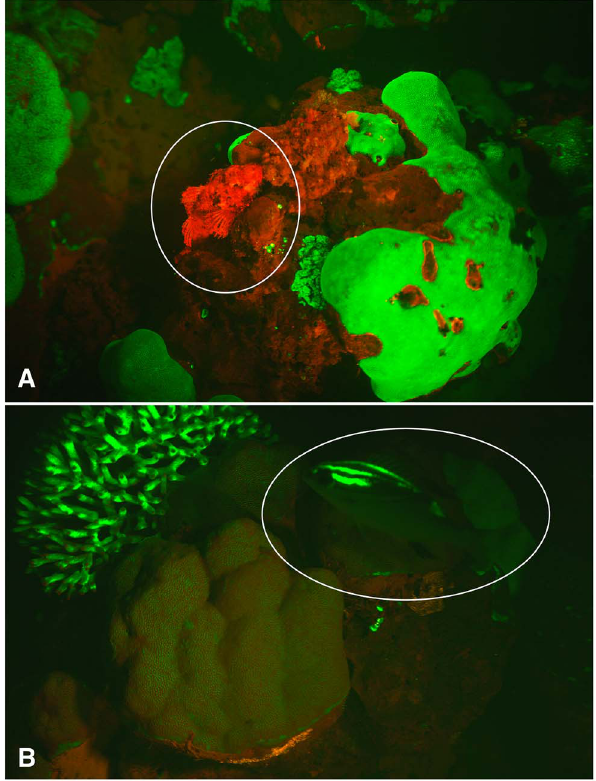
Figure 5. Images of reef fishes fluorescing in their natural habitat captured with a Red Epic video camera at night in the Solomon Islands. (A) A red fluorescing scorpionfish, Scorpaenopsis papuensis , perched on red fluorescing algae. (B) A green fluorescing nemipterid (bream), Scolopsis bilineata , near a green fluorescing Acropora sp. coralhead.